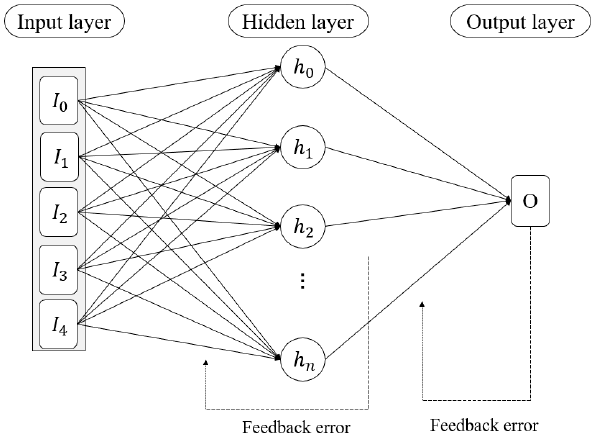
Figure 3. Architecture of the LSTM model used in our paper.